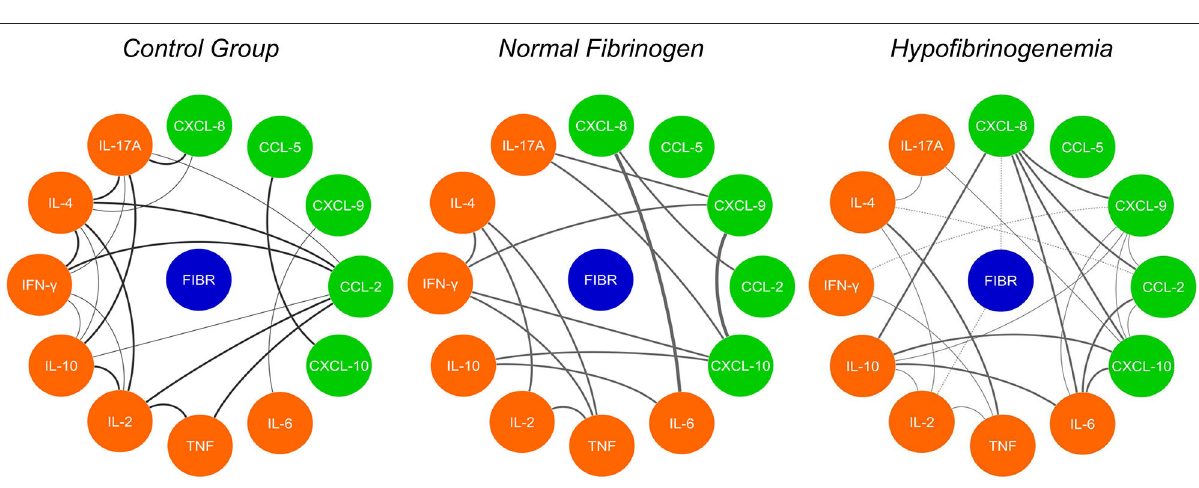
FIGURE 5 | Network correlation of soluble molecules shows interactions occurring throughout the fibrinogen levels and interaction of the molecules in the control group (CG). Each group of colored nodes is used to identify chemokines (green), cytokines (orange), and fibrinogen (blue). Dashed lines indicate negative correlation and continuous lines in black, positive correlation, while thickness shows correlation strength. The correlation index ( r ) was used to categorize the correlation strength as weak ( r ≤ 0.35), moderate ( r ≥ 0.36– r ≤ 0.67), or strong ( r ≥